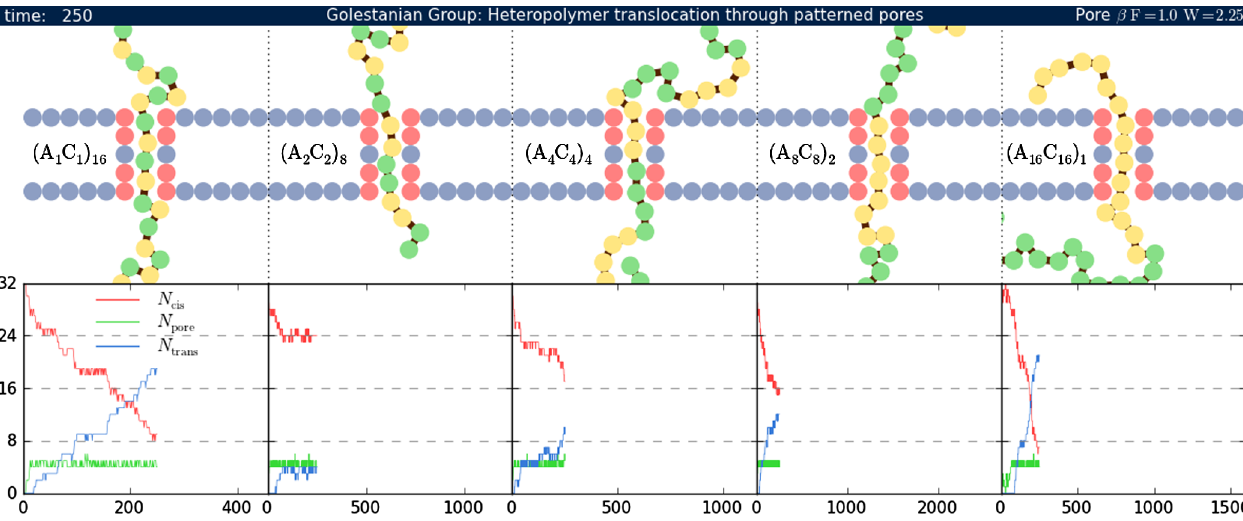
VIDEO 2. Heteropolymers translocating through Pore (cid:3) . Heteropolymers of length N ¼ 32 with block lengths 1, 2, 4, 8 and 16 translocating through Pore (cid:3) . Monomer type A (yellow) has an interaction energy three times larger than that of B (green). The top panel shows a view of the simulation near the pore region, which consists of attractive (red) and short-range repulsive (blue) patches. Pore (cid:3) is symmetric with a repulsive core. The total number of monomers in the cis (red), pore (green), and trans (blue) side are counted as a function of time in the lower plot. The runs selected have a translocation time near that of the mean of the distribution of translocation times for the particular structure. The parameters, as explained in the paper, are W ¼ 2 : 25 and F ¼ 1 : 0 .